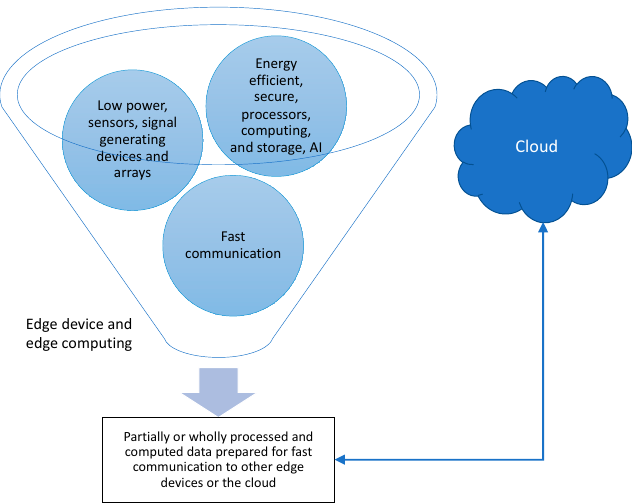
Figure 2. Some basic elements of a device in the edge computing paradigm. The edge device does not necessarily require a connection with a centralized cloud. Many challenges lie ahead regarding energy efficiency, data quality and reliability, data and device security, computing performance level, etc., stimulating exploration for novel nanosystems and processor architectures, rapid communication, and related components.